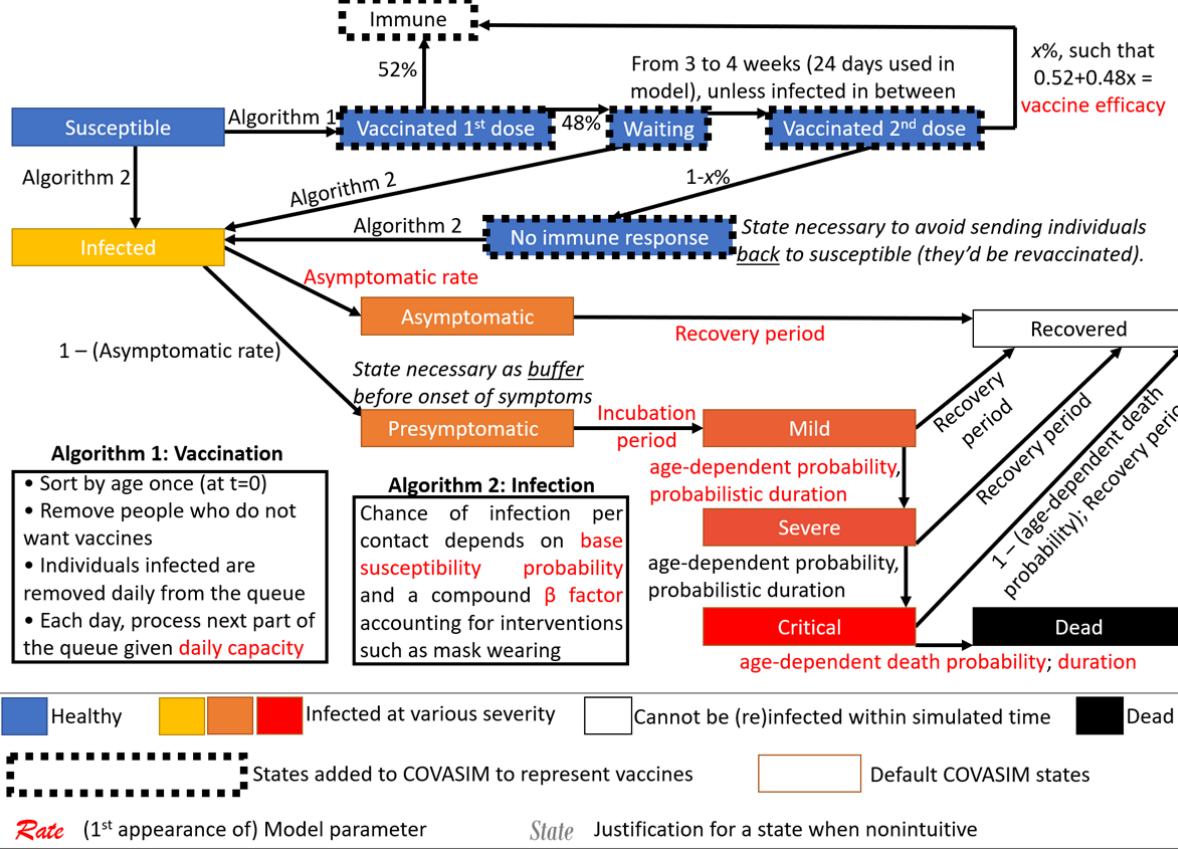
Figure 1. Overview of our modified COVASIM model containing the state diagram and specification of all transitions, including key procedures for vaccination and